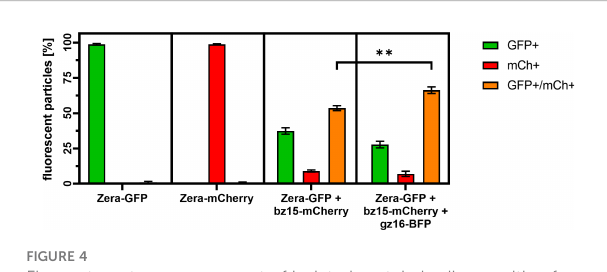
FIGURE 4 Flow cytometry measurement of isolated protein bodies resulting from the expression of a single zein-fusion (Zera-GFP or Zera-mCherry), the co-expression of Zera-GFP and 15-kDa- b – zein-mCherry (Zera- GFP + bz15-mCherry), or the co-expression of Zera-GFP, 15-kDa- b – zein-mCherry and 16-kDa- g -zein-BFP (Zera-GFP + bz15-mCherry + gz16-BFP). The percentage of GFP-positive (GFP+, green bar), mCherry-positive (mCh+, red bar), and double-positive (GFP+/mCh+, orange bar) particles is shown. Values for three independent measurements are shown. A t-test was performed, p > 0.05, ** p ≤ .01.